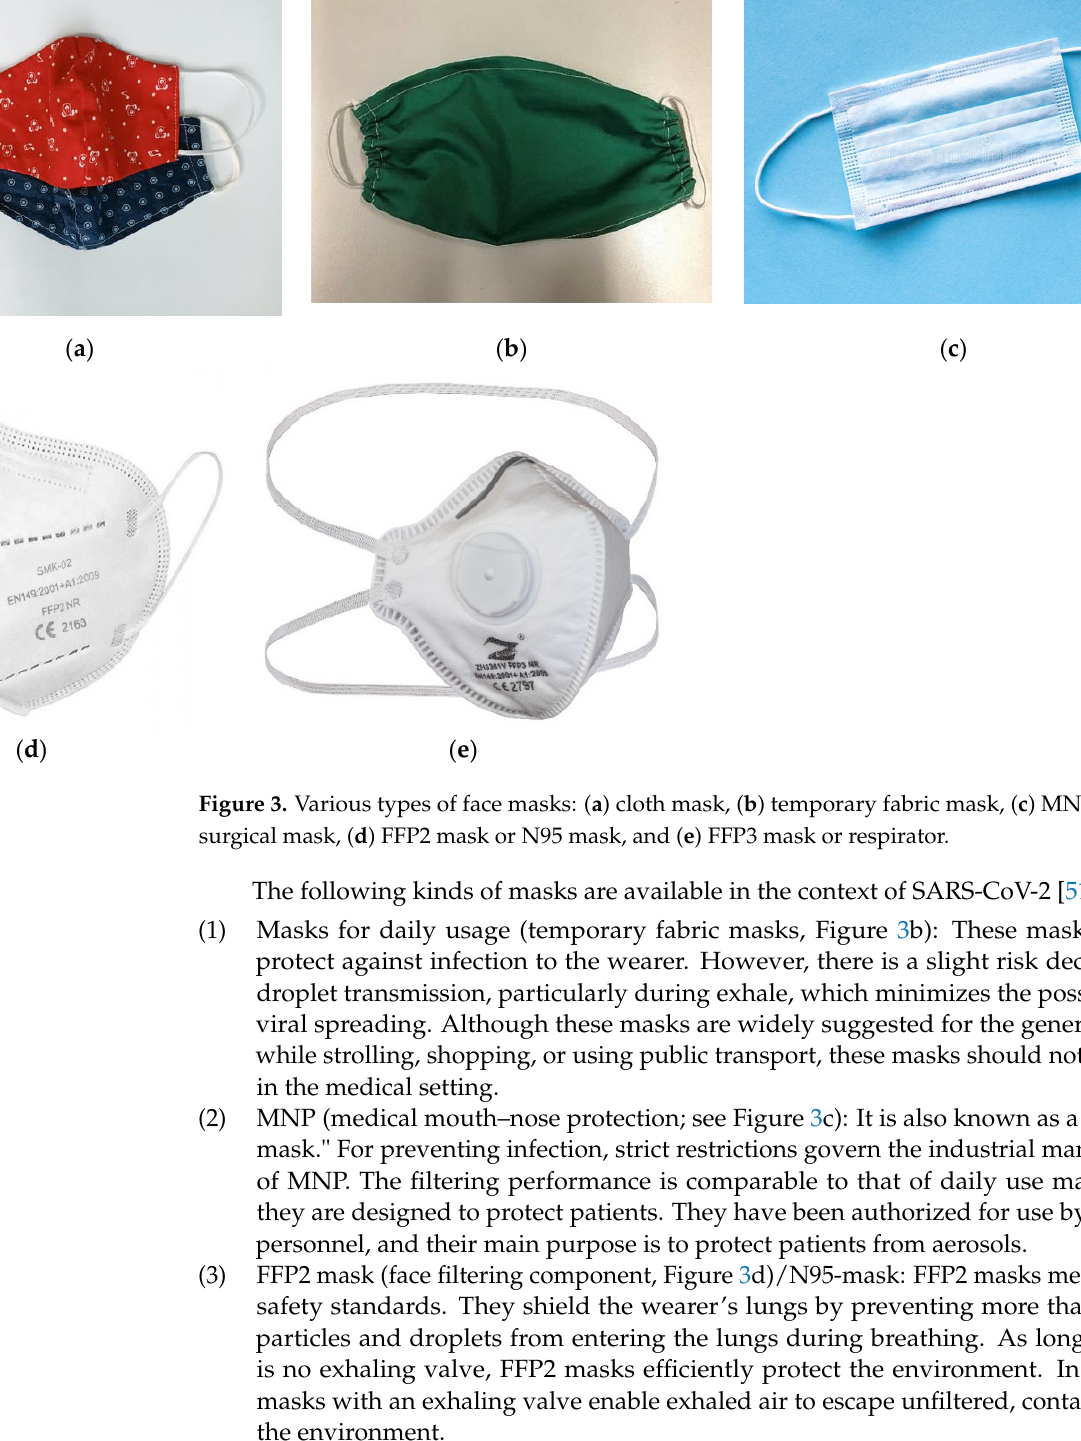
FFP3 mask: FFP3 masks (Figure 3e) protect the user even better than FFP2